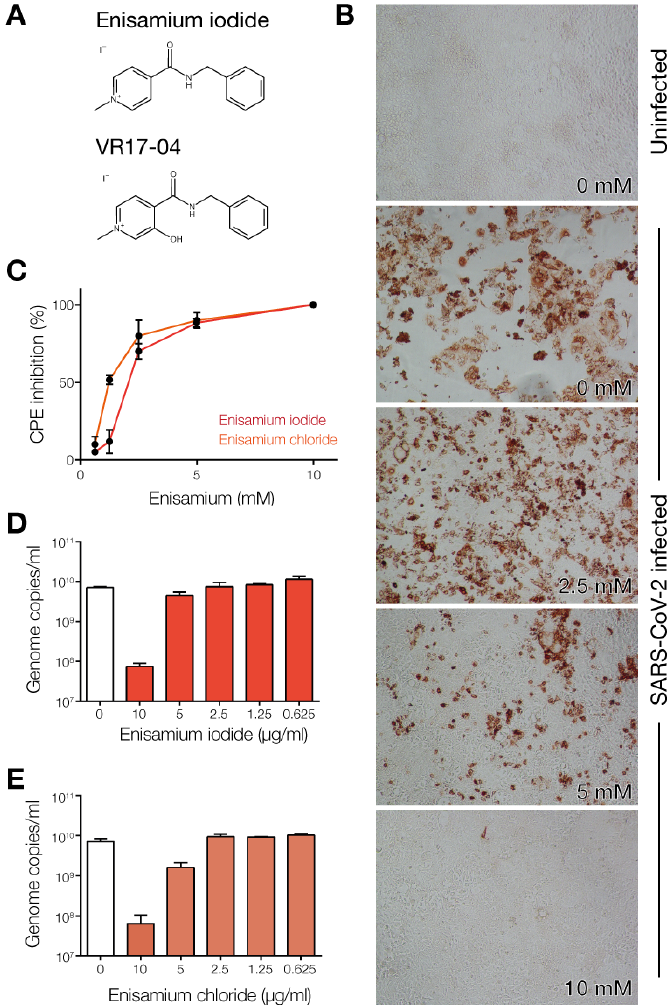
Figure 1. Enisamium inhibits SARS-CoV-2 infection of Caco-2 cells in vitro. ( A ) Chemical structures of enisamium iodide (FAV00A) and VR17-04. The chemical structure of FAV00B is identical to FAV00A except that chloride ions are present instead of iodide. ( B ) Inhibition of SARS-CoV-2 N expression by enisamium chloride in Caco-2 cells. ( C ) Inhibition of SARS-CoV-2 cytopathic effect by enisamium iodide and chloride in Caco-2 cells. ( D ) Effect of enisamium iodide or ( E ) enisamium chloride on SARS-CoV-2 infected Caco-2 cells.